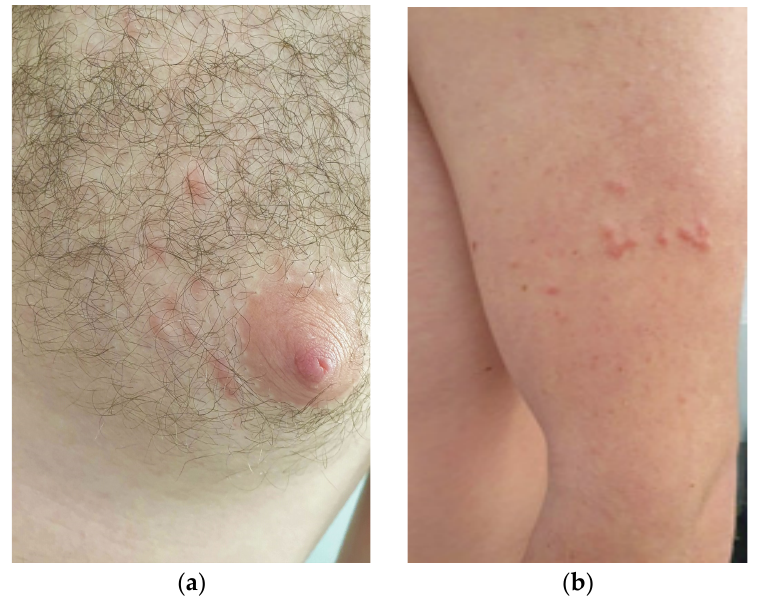
Figure 1. ( a ) Multiple, cutaneous, papulo-erythematous lesions, distributed in the left mammal areas; ( b ) the same patient with other lesions in the upper left limb. These lesions were painful and showed a general segmental (dermatomal-like) distribution.